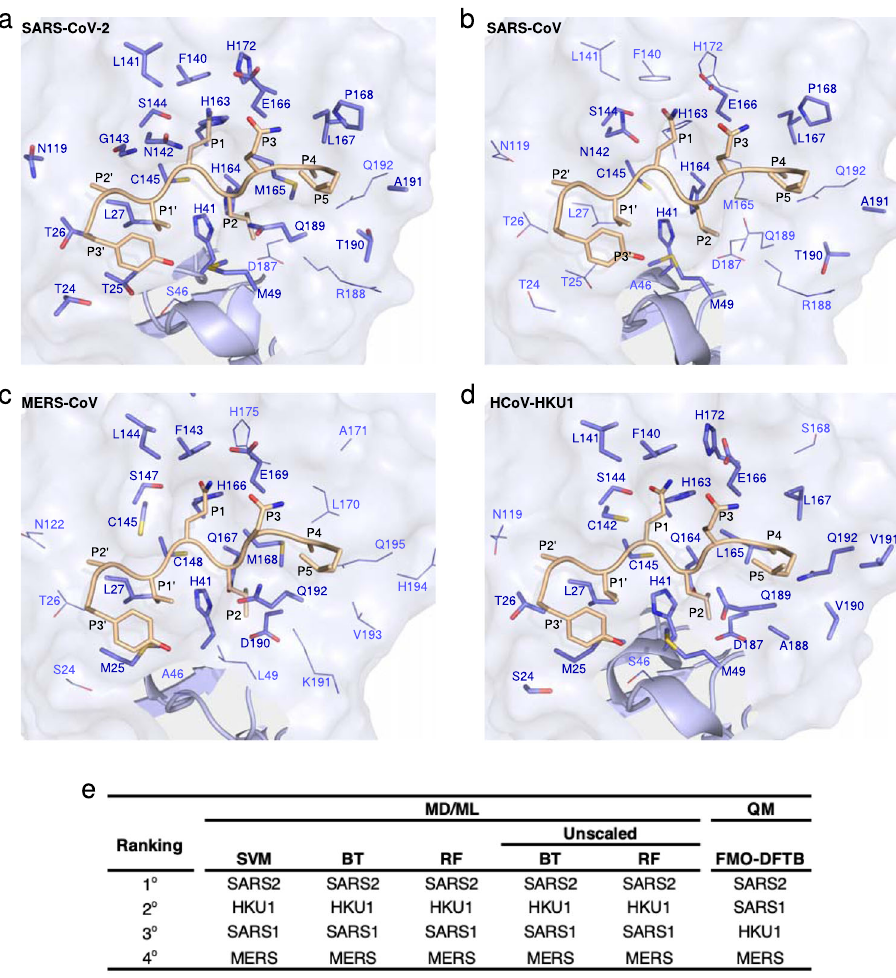
Fig. 4 | Comparative analysis of 3CLpro from human-infecting betacor- onaviruses bound to NEMO. a – d Substrate-binding site of human-infecting beta- coronaviruses with hNEMO 227 – 234 . Contacts that persist for more than 70% of the simulation time are labeled in bold. e Ranking of predicted hNEMO 227 – 234 -binding af fi nities to 3CLpro from betacoronaviruses computed with quantum mechanics (QM) and molecular dynamics/machine learning (MD/ML) approaches. SARS-CoV- 2, SARS-CoV, HCoV-HKU1, and MERS-CoV are abbreviated as SARS2, SARS1, HKU1, and MERS, respectively. In the MD/ML approach, fi ve machine learning methods were used to train the model, namely, support-vector machine (SVM), gradient-